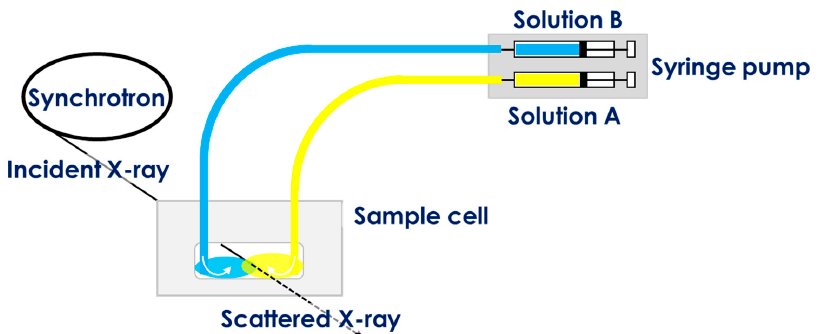
Figure 2. Schematic illustration of the custom sampling system designed to enable time-resolved small angle X-ray scattering (SAXS) measurements of alginate samples.